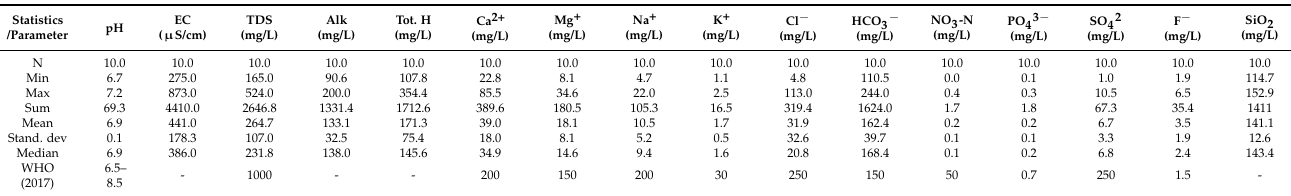
Table 3. Summary statistics of the groundwater physicochemical